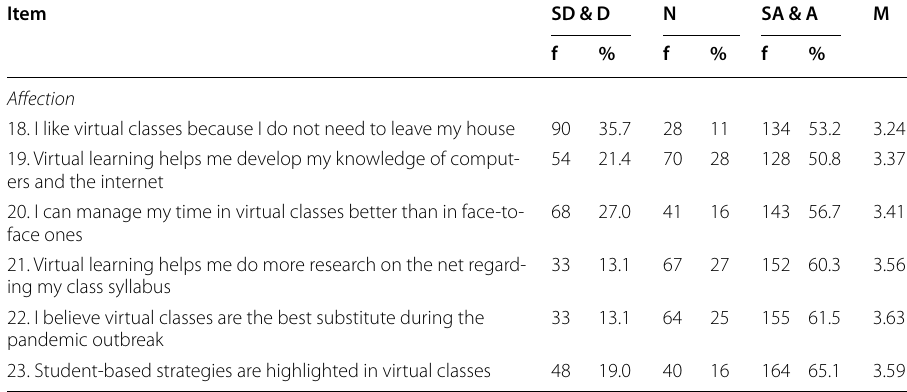
Table 9 Frequency, percentage, & mean score for responses to APPRSQ (affection)